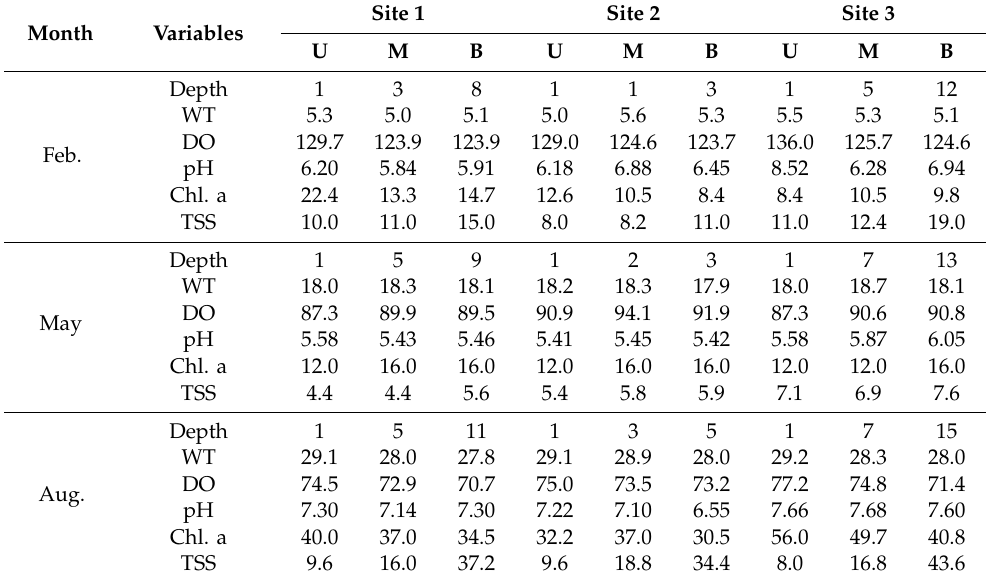
Table 1. Seasonal environmental variables at each site of the Nakdong River Estuary. Depth, Water depth (m); WT, Water temperature ( ◦ C); DO, Dissolved oxygen (%); Chl. a, Chlorophyll a ( µ g · L –1 );